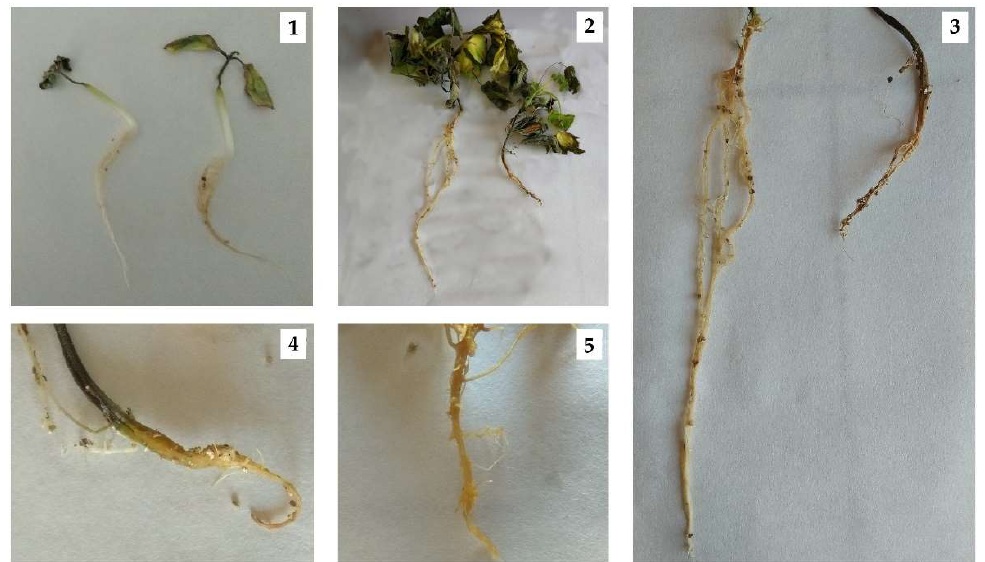
Figure A1. Underground symptomatology of P. capsici and Fsc . P. capsici (left) and Fsc (right) 14 dpi in seedlings ( 1 ). P. capsici (left) and Fsc (right) 21 dpi in plants inoculated when they reached 2–3 true leaves ( 2 , 3 ). Soaked and constricted crown and main root disaggregation caused by Fsc ( 4 ), main root browning caused by P. capsici ( 5 ) 14 dpi. Note that these cucurbits had a fibrous root system (generate more than one main root), but, in the young plants, a main root is clearly observable.